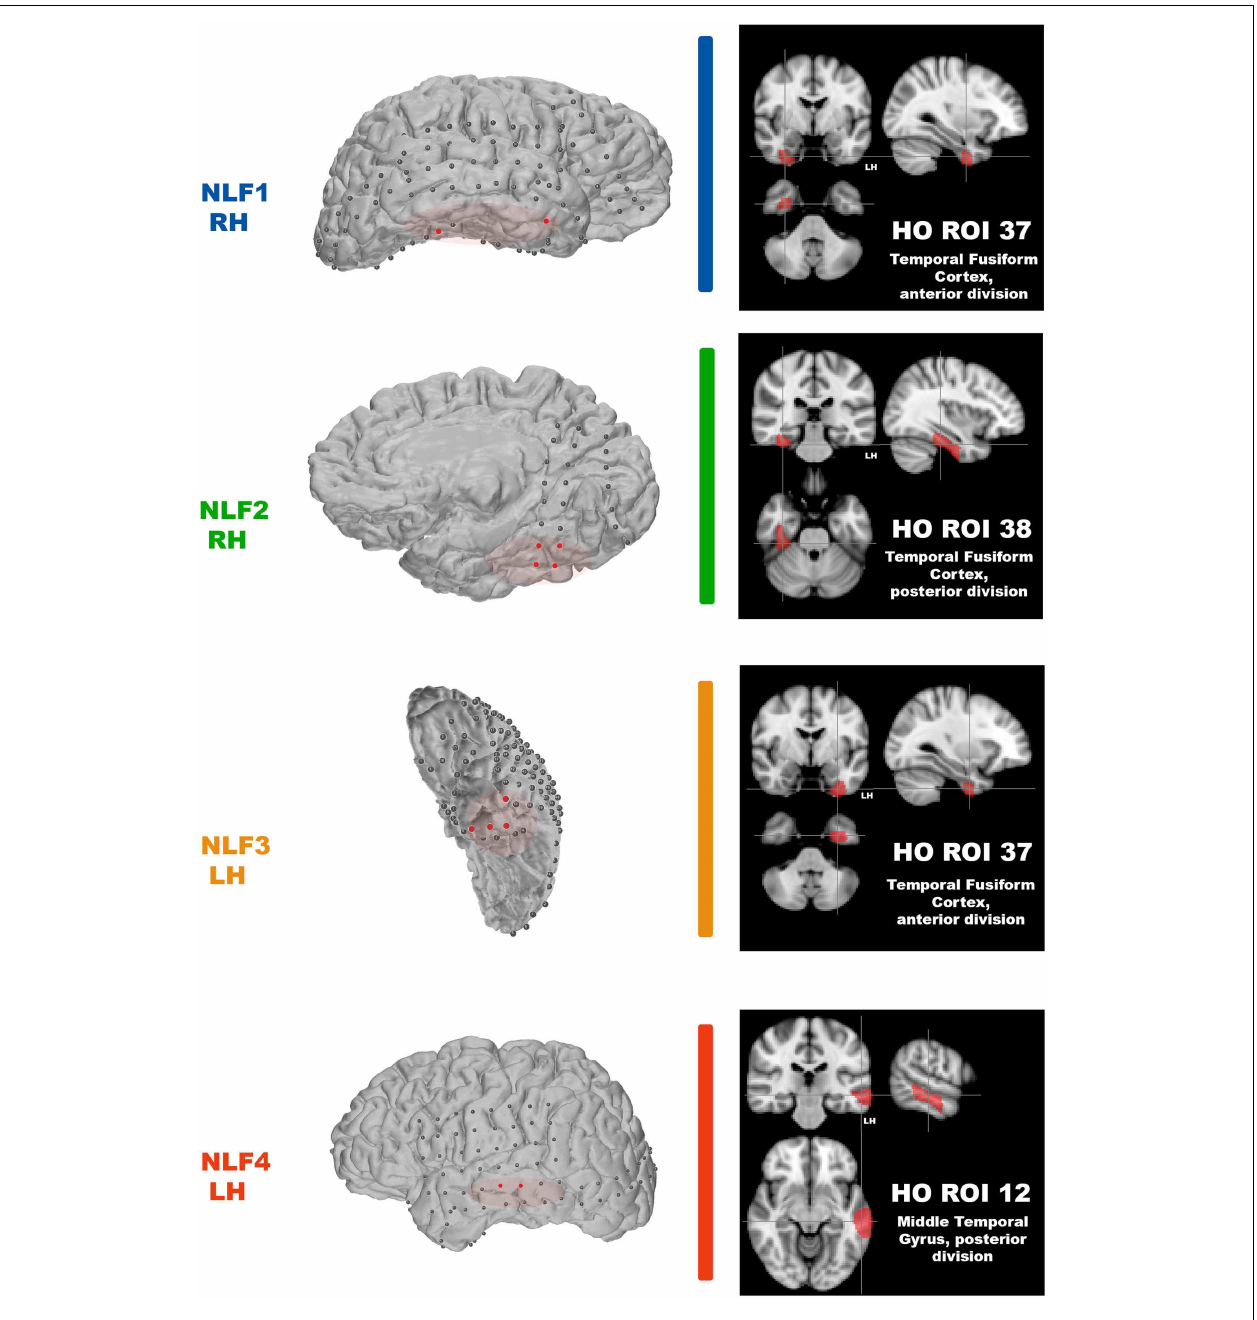
automated tools for surface reconstruction) with the overlaid ECoG grid and strip electrodes. Electrodes colored in red reveal the locales of the ECoG recorded ictal onset activity.The overlaid red transparencies show the approximate resected, epileptogenic zone.The second column (black boxes) plots the HO ROI (on the MNI 152 brain) that overlaps with the electrode falling within the seizure focus for each NLF